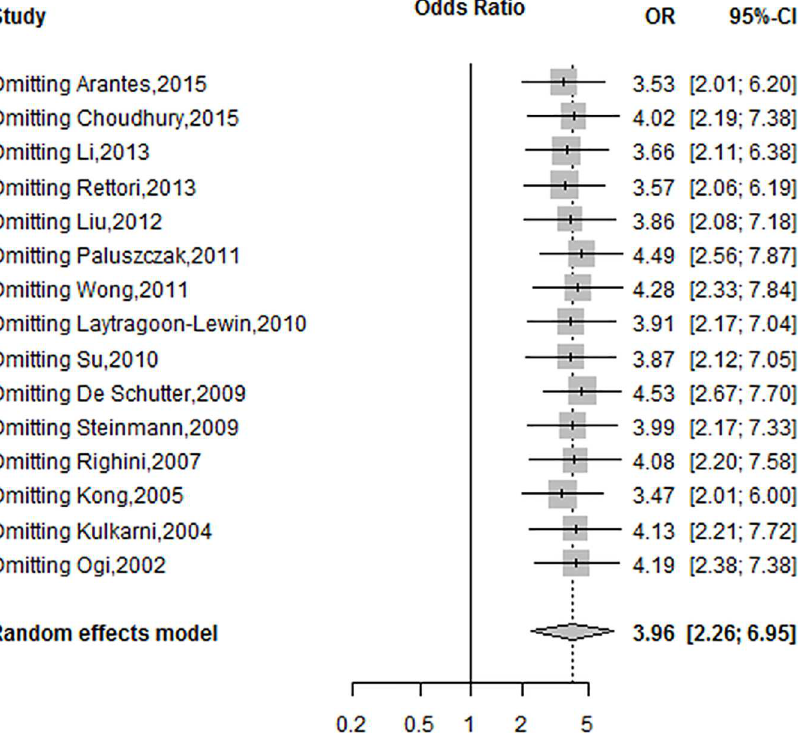
Fig 4. Sensitivity analysis of DAPK promoter methylation and HNSCC by the random-effects method.